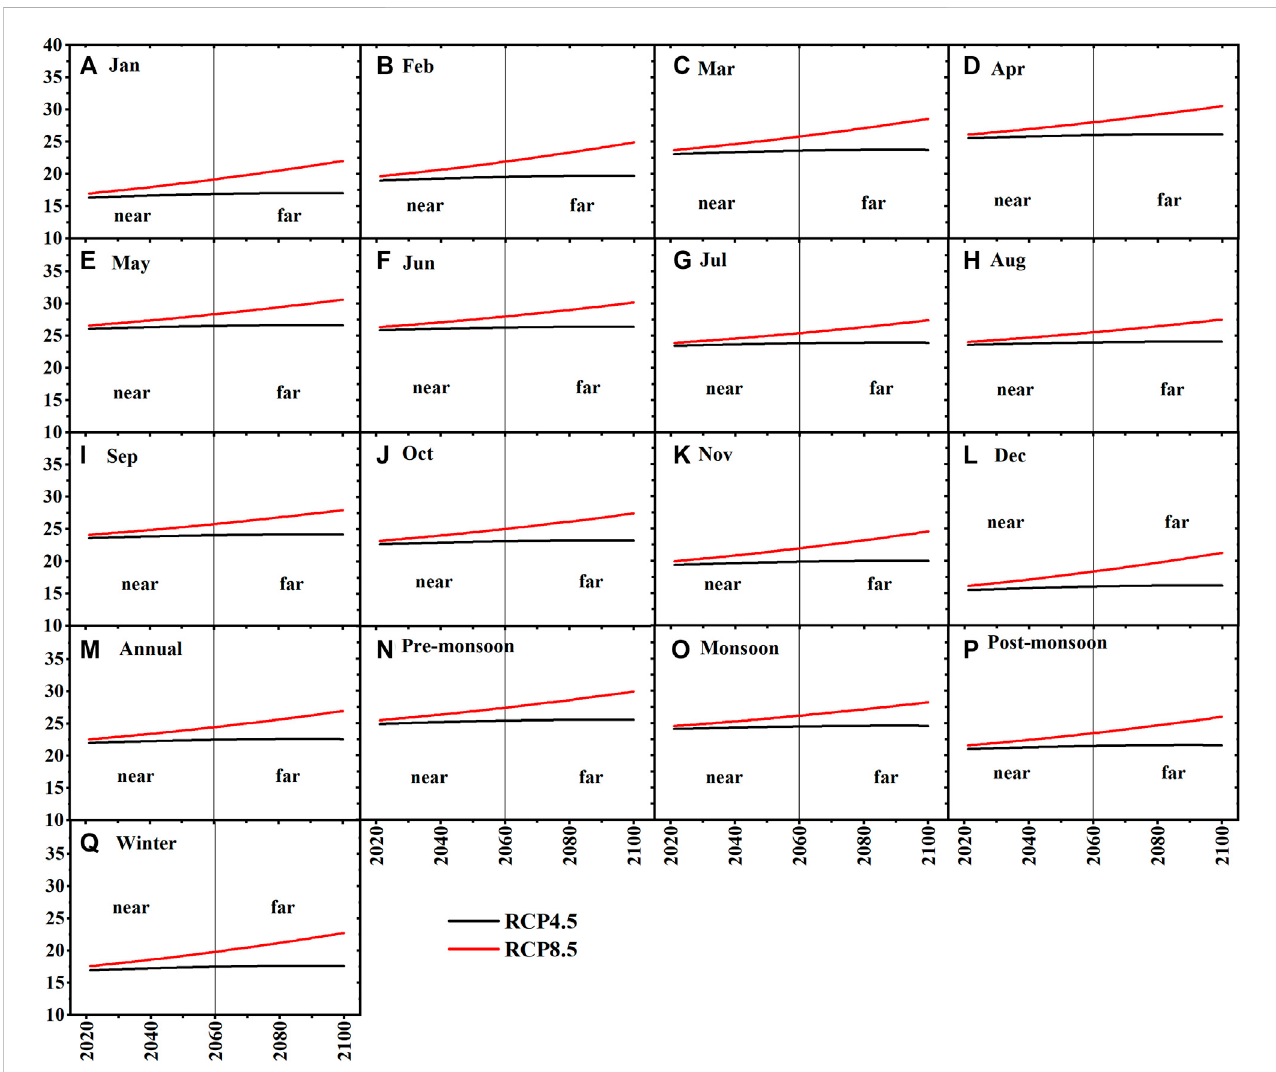
FIGURE 13 Monthly, Annual and Seasonal Tmin ( o C) variability of multi-model ensemble (MME) of CMIP5 dataset under RCP4.5 and RCP8.5 for the near and far periods in Bangladesh. (A) January, (B) February, (C) March, (D) April, (E) May, (F) June, (G) July, (H) August, (I) September, (J) October, (K) November, (L) December, (M) Annual, (N) Pre-monsoon, (O) Monsoon, (P) Post-monsoon, and (Q)